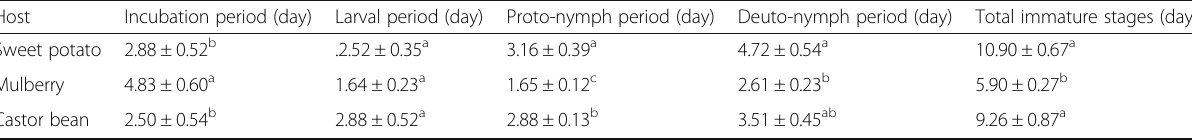
Table 1 Impact of different host plants on development durations of immature Stages of Tetranychus urticae